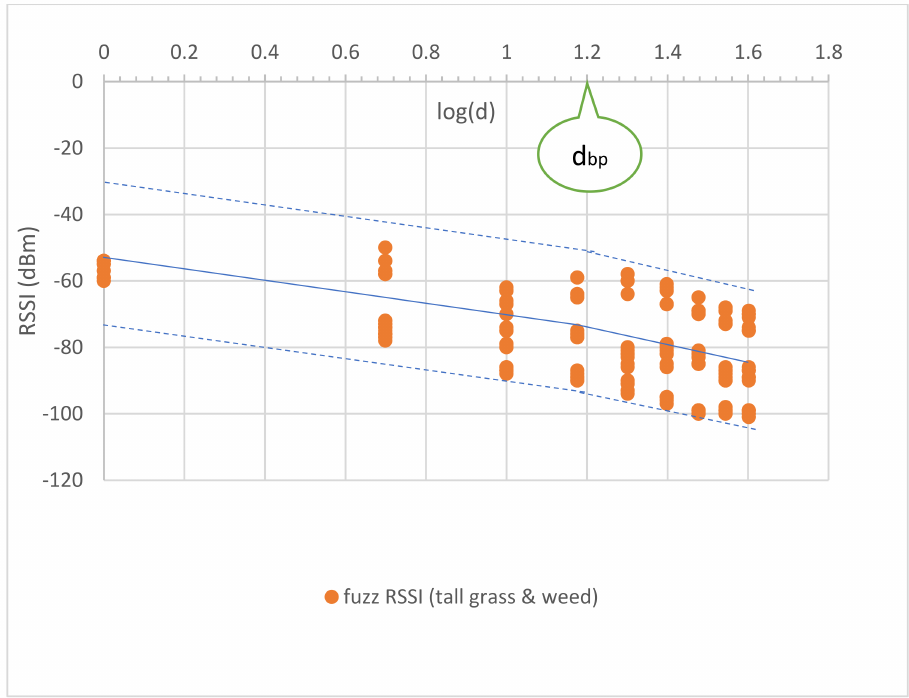
Figure 10. FLR curves for tall grass and weed with membership level